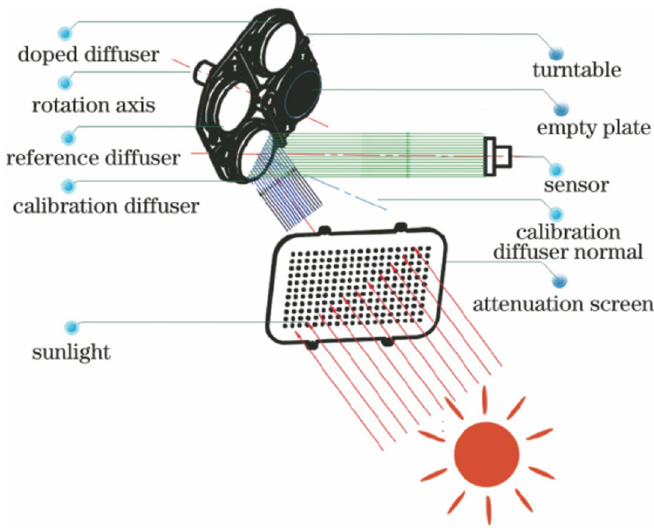
Figure 2. Schematic of onboard calibration system of SCS [28].